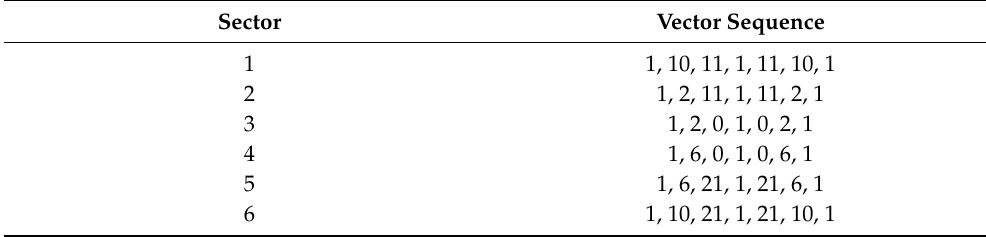
Table A2. Vector switching sequences of the first outer hexagon, by the ith designation (V i ).